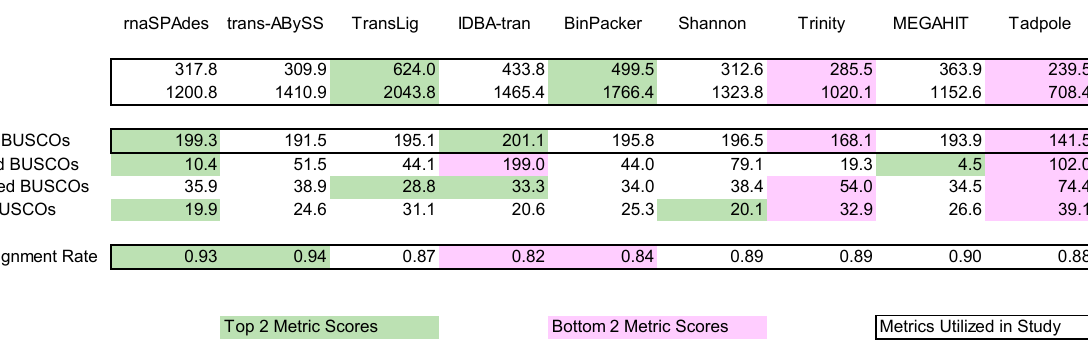
Figure 3. Single-assembly raw average assessment scores. Assessment metrics used in study: n50/n90 (via TransRate), complete BUSCOs (via BUSCO), and overall alignment rate (via HISAT2) are boxed in. Top two metric scores per assessment criteria are highlighted in green. Bottom two metric scores are highlighted in pink. Metrics not boxed in were provided to aid discussion but not for the generation of the average assessment scores.